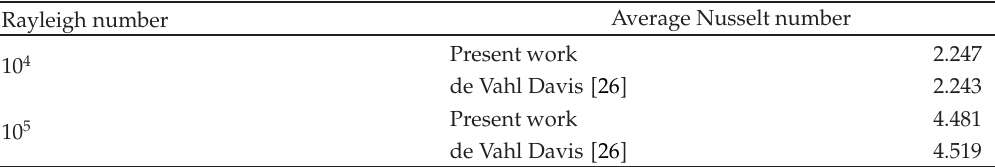
Table 1: Comparison of the predicted average Nusselt number for two di ff erent Rayleigh numbers against the values reported in (cid:6) 26 (cid:7)